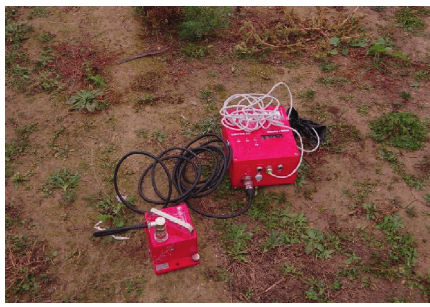
Figure 4: Type 891-II vibrometer. Table 1: Basic parameters of five trains as recorded by the strong motion